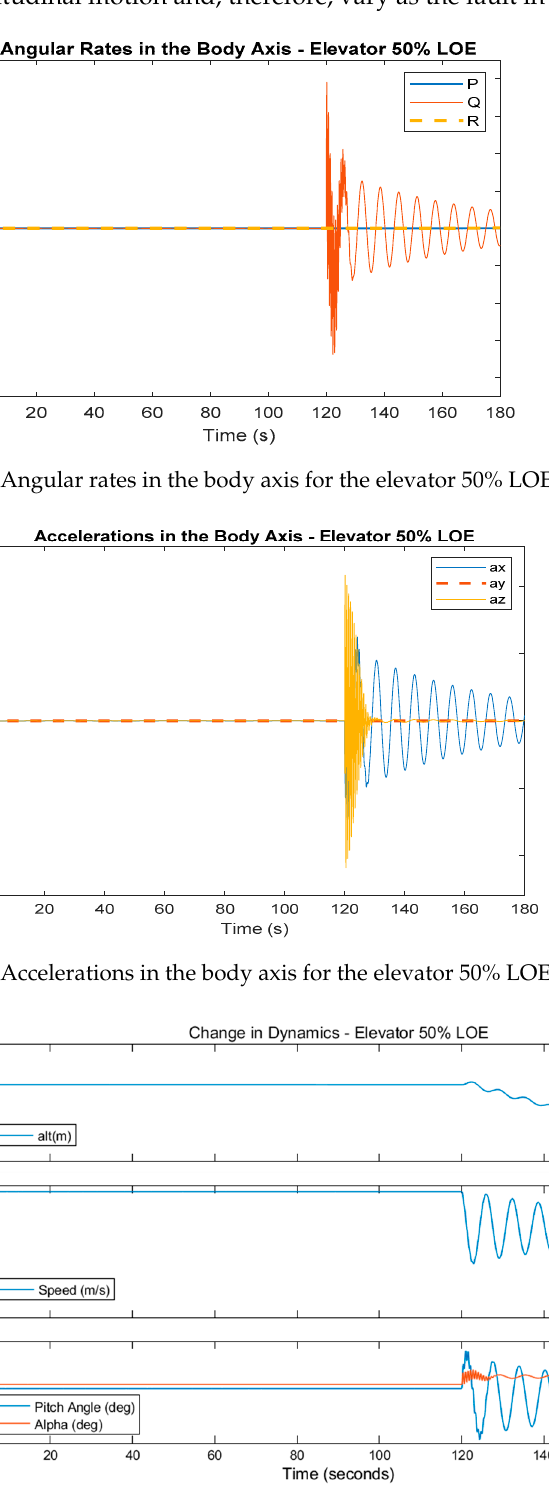
Figure 9. Change in dynamics for the elevator 50% LOE fault.